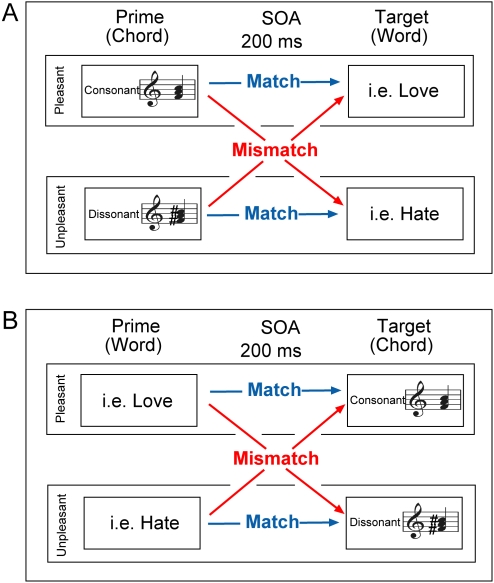
Design of Experiments 1a and 2a (A) and Experiments 2a and 2b (B).In Experiments 1a and 2a chords were presented as primes followed 200 ms after chord onset by target words, which participants were asked to evaluate as fast as possible. In Experiments 1b and 2sb words were presented as primes followed 200 ms after word onset by target chords, which participants were asked to evaluate as fast as possible.